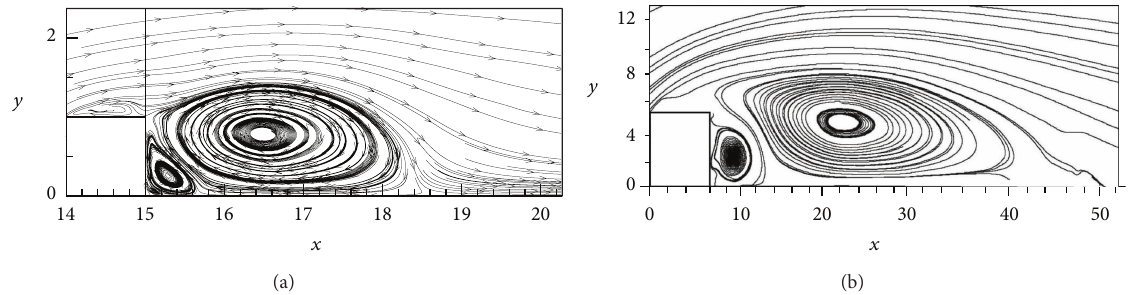
Figure 5: Comparison of streamline patterns under 1: 1 rib aspect ratio and Re = 1920 . (a) Results from our numerical method, while (b) is taken from Agelinchaab and Tachie [16].